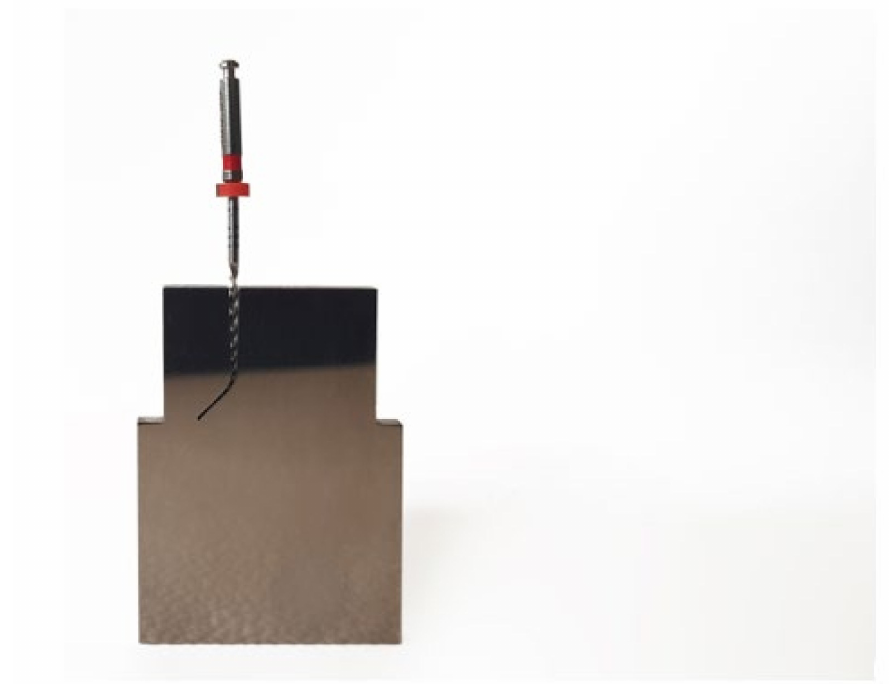
Figure 2. Artificial root canal manufactured from stainless steel with EDM molybdenum wire-cut technology in close contact with a NiTi alloy endodontic rotary